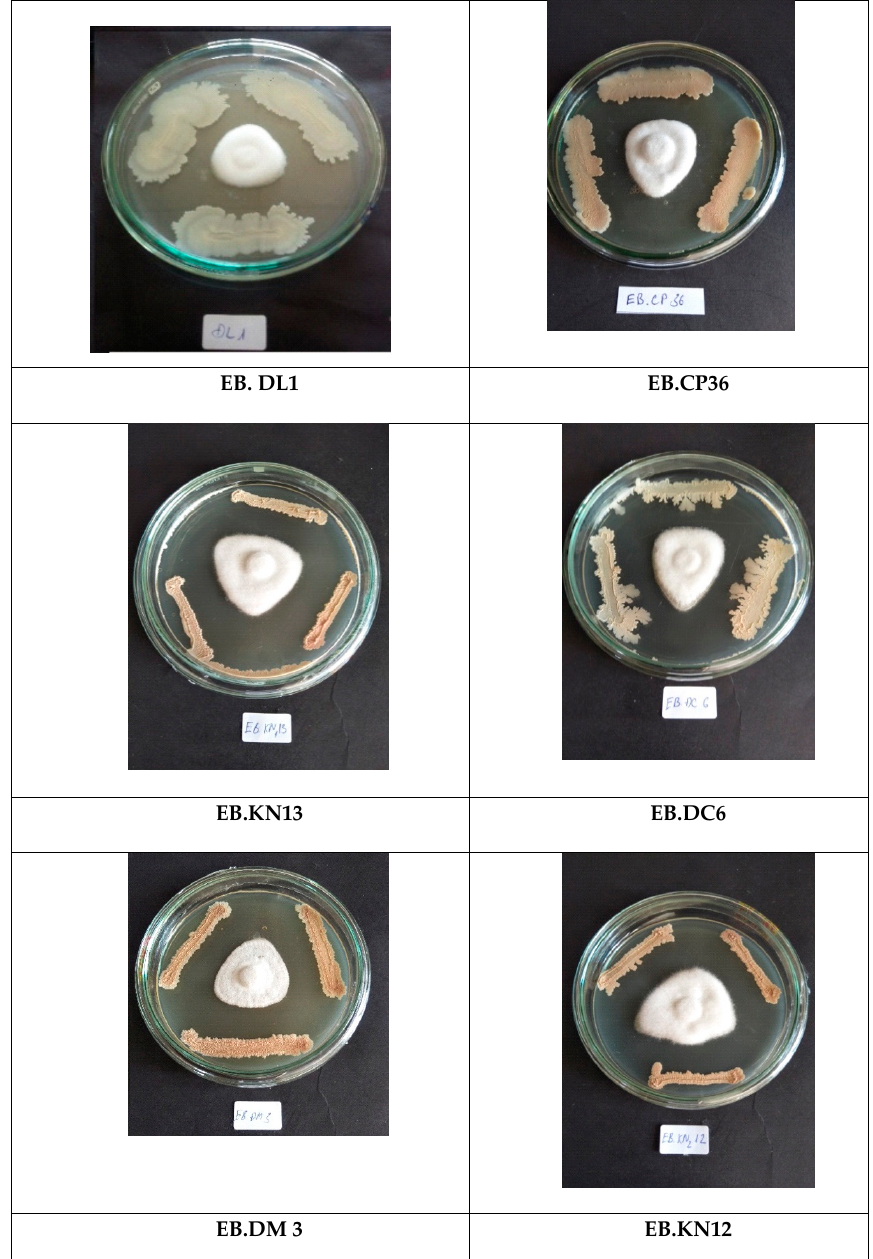
Figure 3. In vitro antagonism of the selected endophytic bacteria against Phytophthora . Phytophthora and endophytic bacteria were grown on PDA medium. Phytophthora placed in the center of the medium and endophytic bacteria streaked 2 cm on three side of it. The plates were incubated at 30 °C for 5 d to evaluate the activity. Characters boxes are names of isolates. The morphology of the six selected endophytic bacteria is shown in Figure 4. They are Gram positive rod-shaped bacteria and the colonies have convex irregular shape, slotted surface, with translucent, opaque, and brilliant color. The morphology of the bacteria had the characteristics of